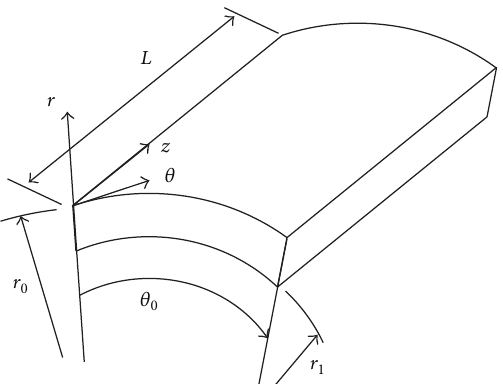
Figure 1: Cylindrical panel and its